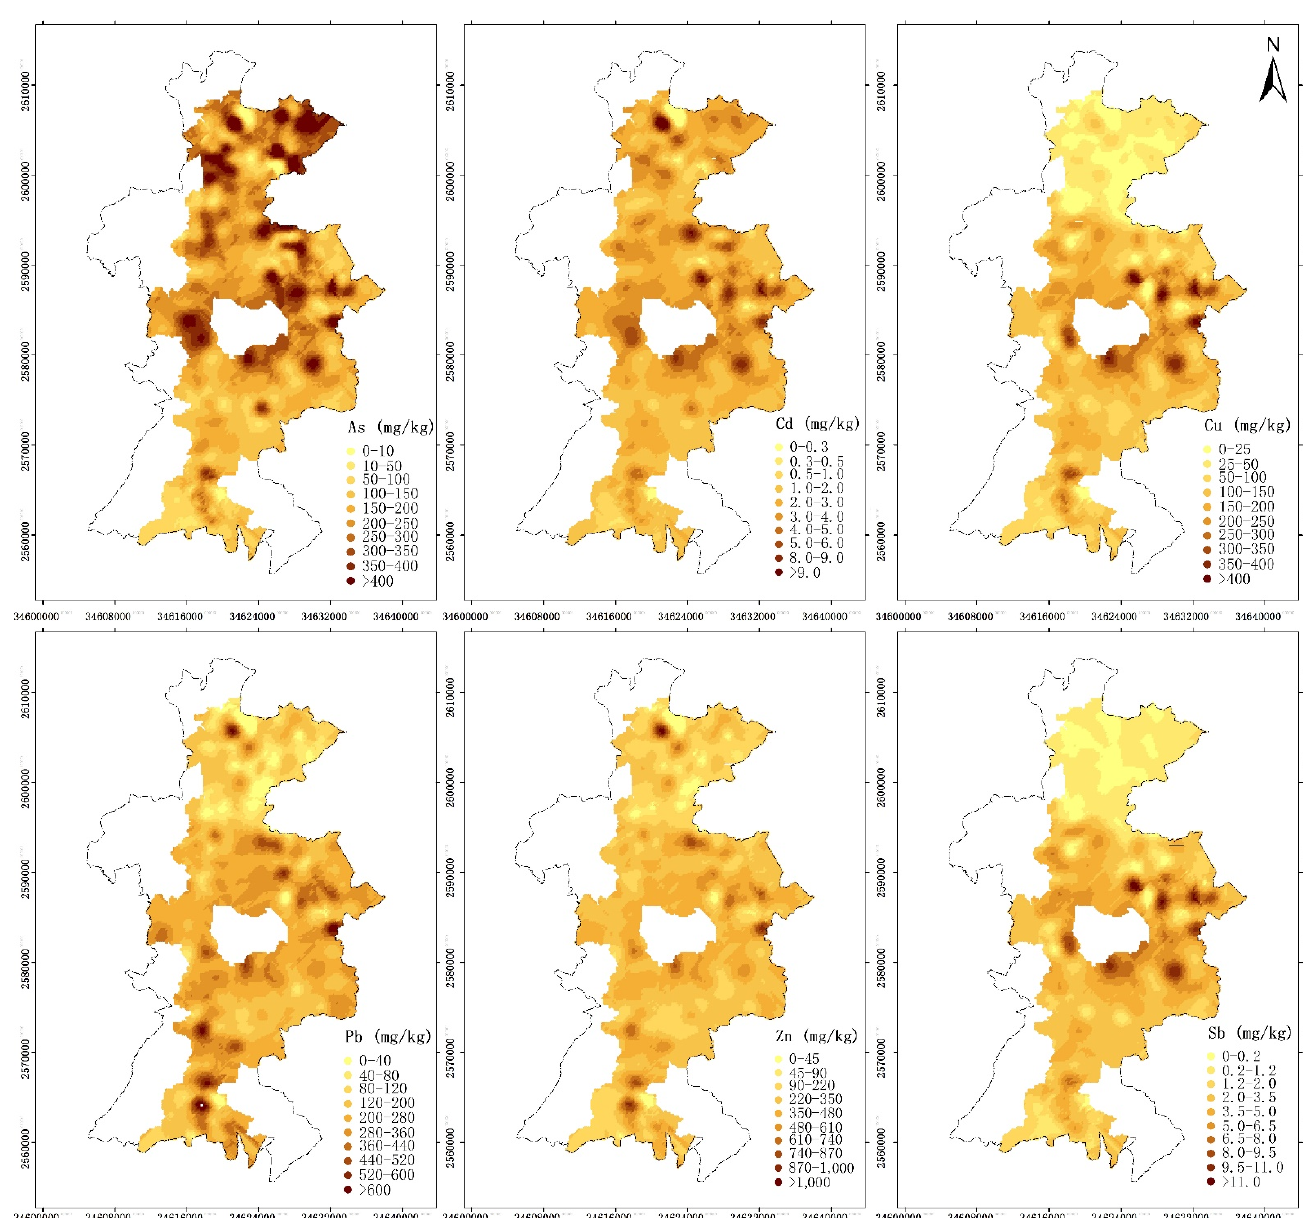
Figure 3. Spatial distributions of heavy metals obtained via PMF.